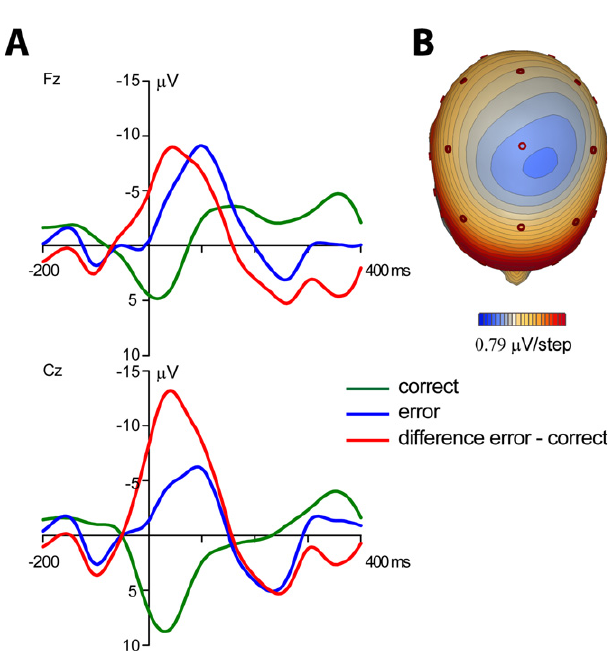
Figure 2. Event-related potentials from the OCD-patient. Pretest prior to the operation. (A) Event-related brain responses time-locked to the button press response recorded from the scalp (Fz, Cz sites referenced to average activity at the two mastoid processes). (B) The topographic map shows the distribution of the patient’s ERN. A typical fronto-central maximum is